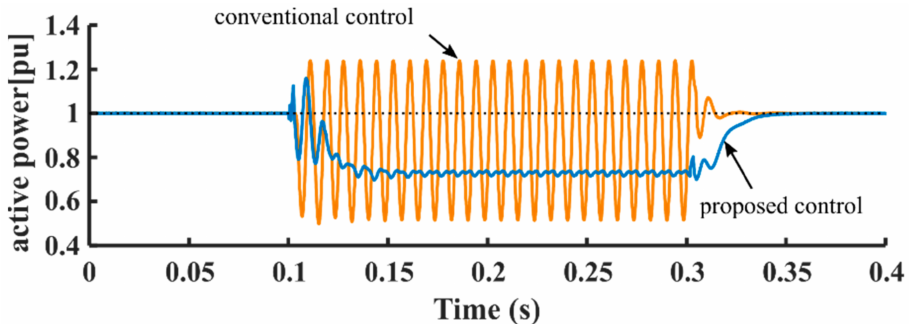
Figure 14. Comparison of active power with conventional and proposed feedforward control method under SLG